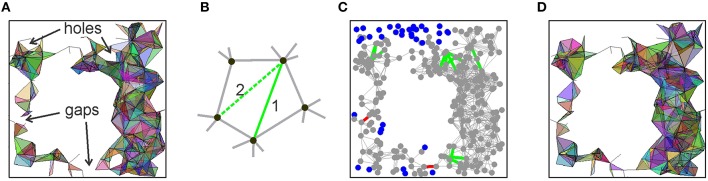
Correction algorithms. (A) A spatial projection of the 2D skeleton of T(θ) shows gaps and holes that compromise, respectively, the piecewise and path connectivity of T(θ). If the links across the gaps and holes of T(θ) are restored, then its correct connectivity structure may be regained. (B) A “hole” produced by five connected vertexes is closed by restoring some of the previously discarded crosslinks. (C) A projection of the relational graph G into the environment, shown in gray. The edges added across the gaps are shown in red and the edges added to fill the holes are shown in green. The vertexes that are left disconnected due to low appearance rates of the edges connecting them to other vertexes are shown by blue dots. (D) A spatial map of the resulting “patched” 2D skeleton of T(θ). The parameter values are ng = 15, mh = 10, and the lowered threshold for reintroducing the missing links is θ = 50.